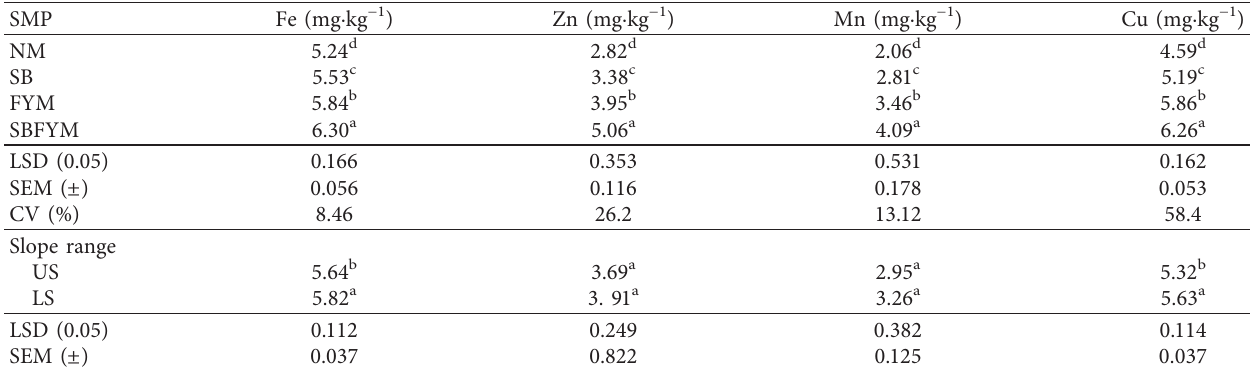
Table 8: Effect of soil management practices and slope ranges on micronutrient cations in soils of Mawula watershed. SMP